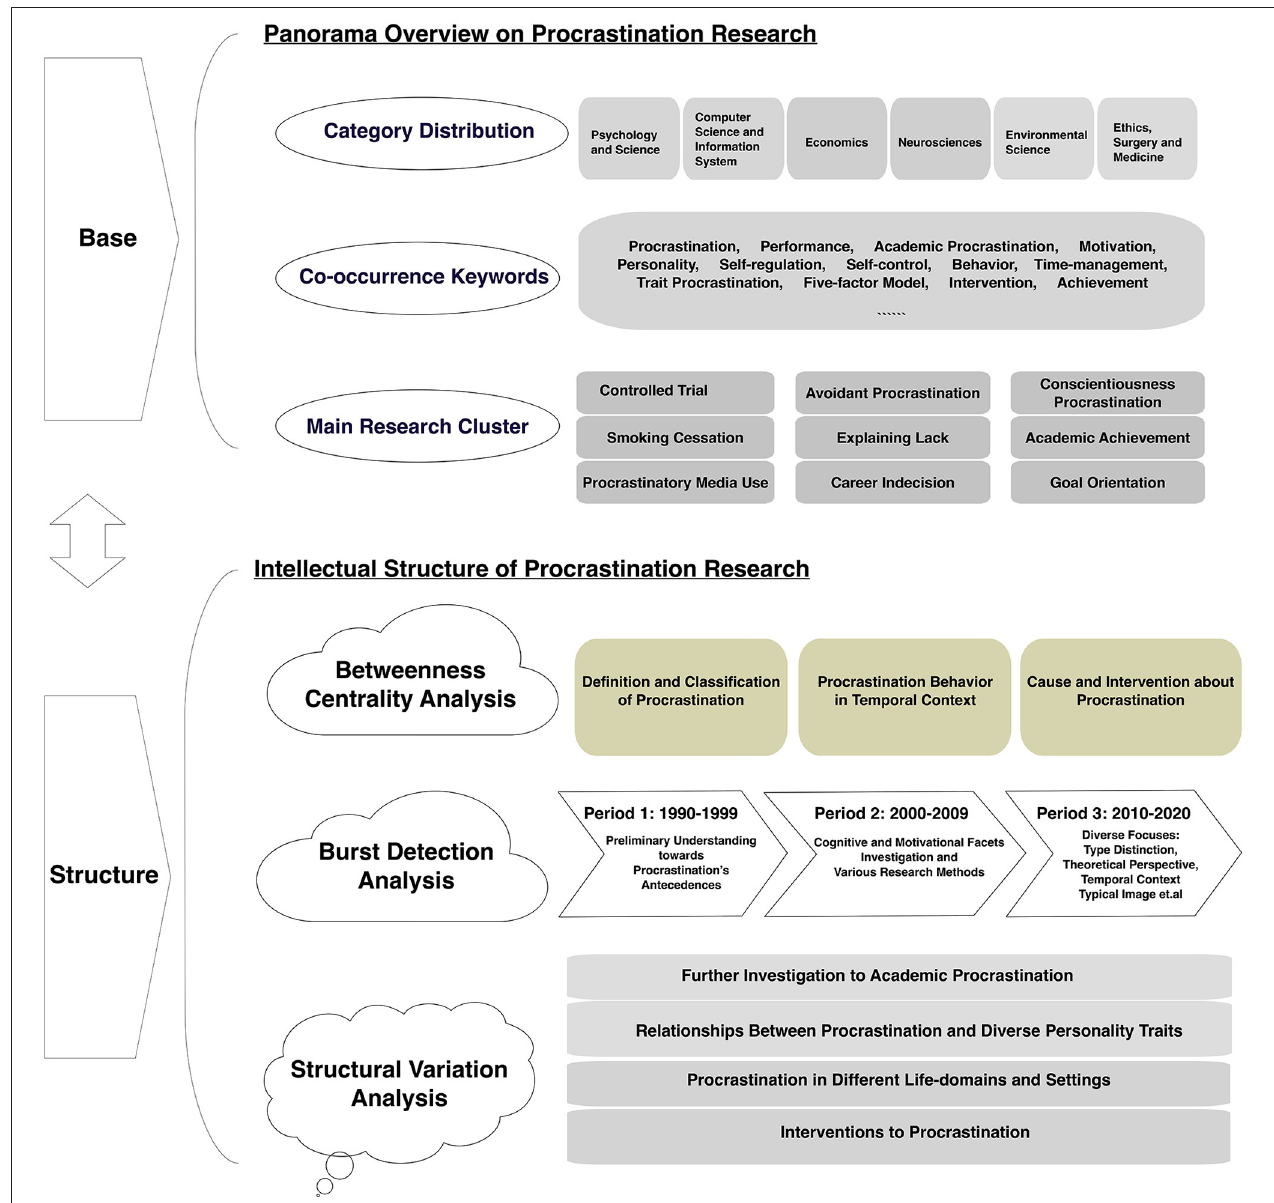
FIGURE 6 | Bibliometric analysis and science map of the literature on